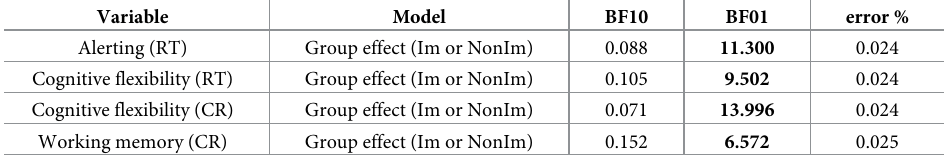
Table 5. BF resulting from Bayesian ANOVAs on alerting, cognitive flexibility, and working memory measures in Grade 2. Variable Model